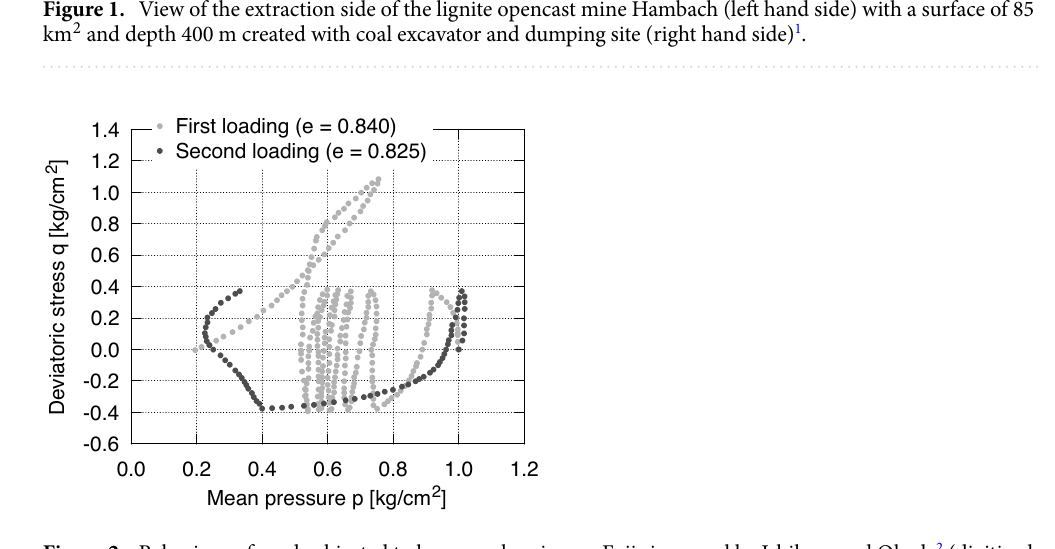
Figure 2. Behaviour of sand subjected to large preshearing on Fuji river sand by Ishihara and Okada 2 (digitized